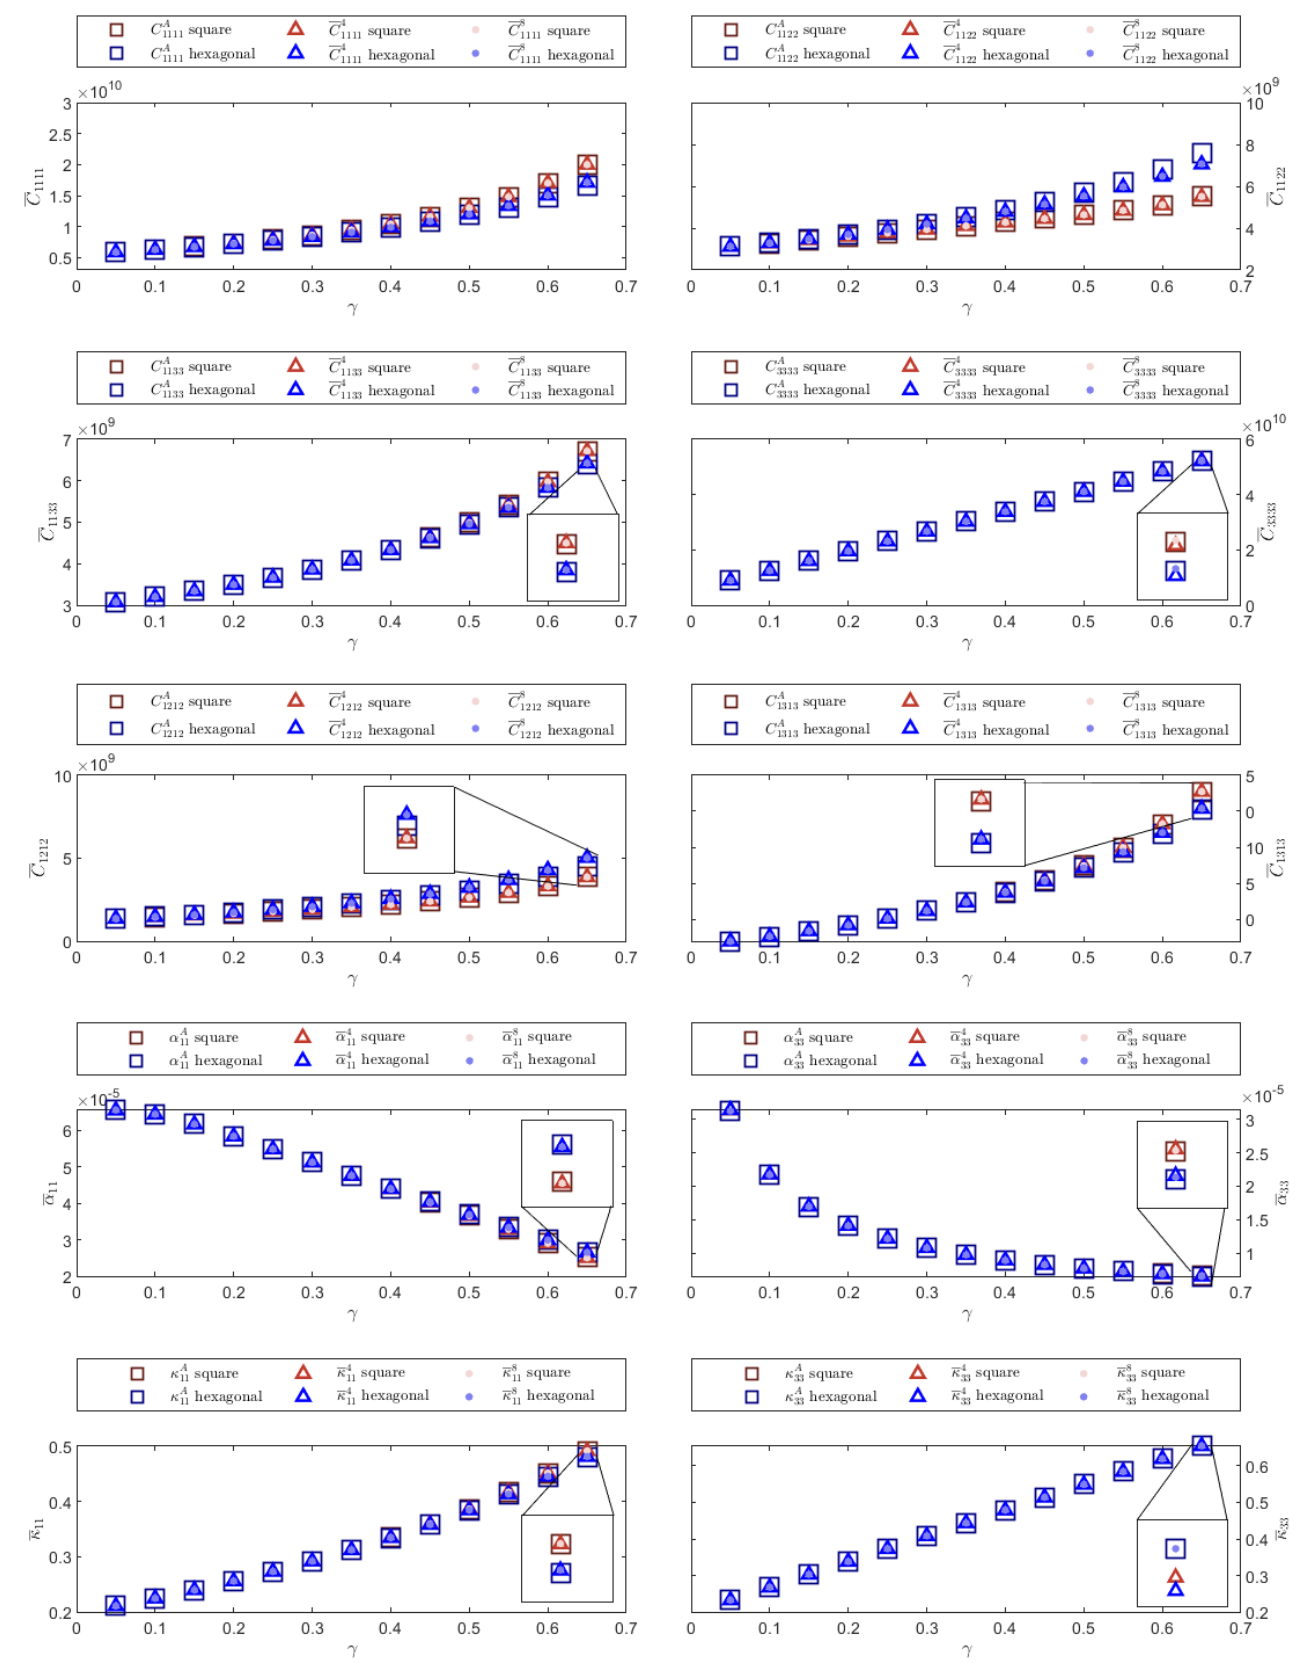
Figure 5. Effective properties for Al-B-Si/Epoxy composite material for square and hexagonal